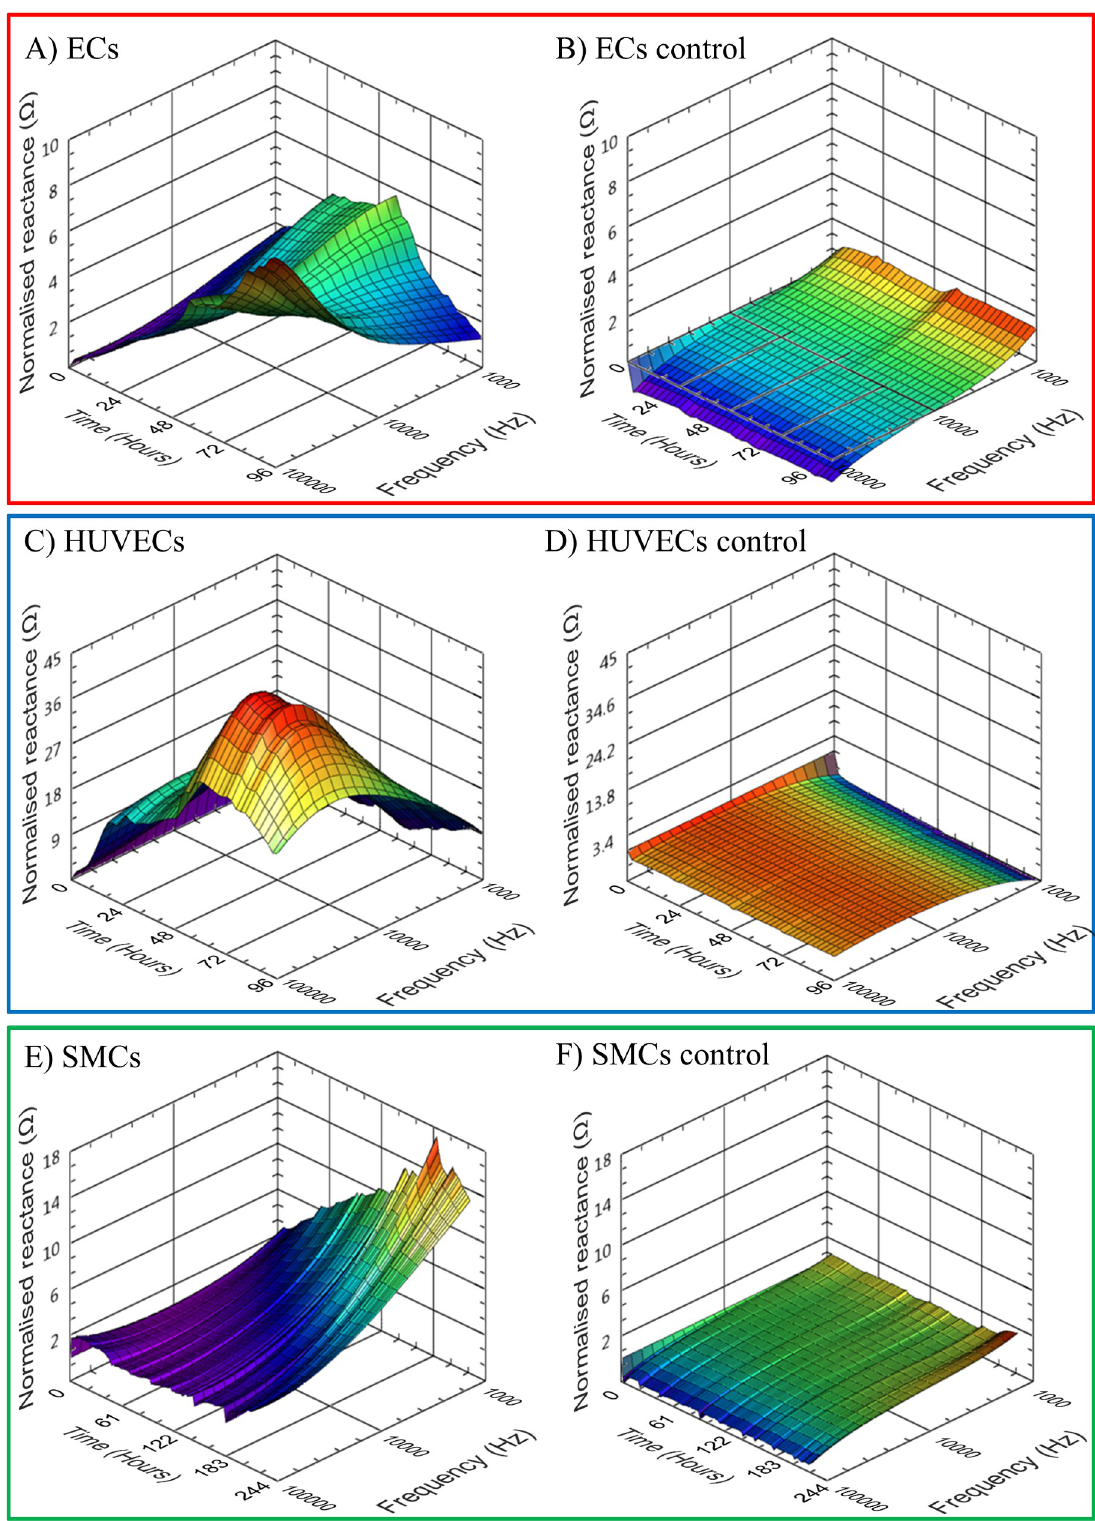
Fig 6. Mean electrode 3D normalised reactance profiles for duration of culture. (A) ECs n = 38, max SEM = 0.908, (B) EC control, n = 33, max SEM = 0.405, (C) HUVECs, n = 14, max SEM = 3.354, (D) HUVEC control, n = 10, max SEM = 1.054, (E) SMCs n = 8, max SEM = 1.861 and (F) SMC control, n = 8, max SEM = 0.778.